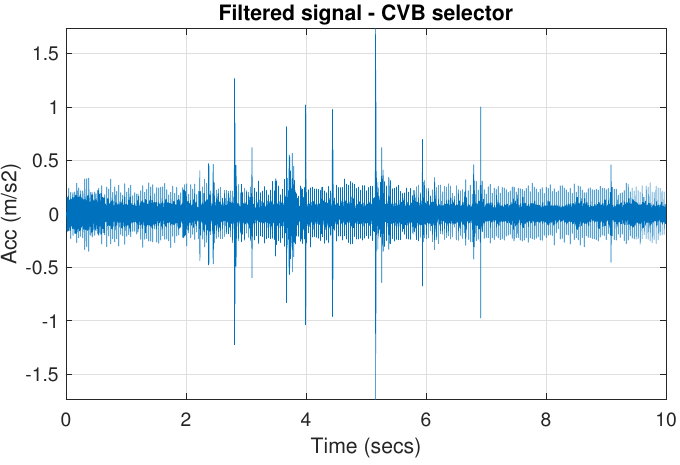
Figure 44. Filtered signal r by CVB selector.